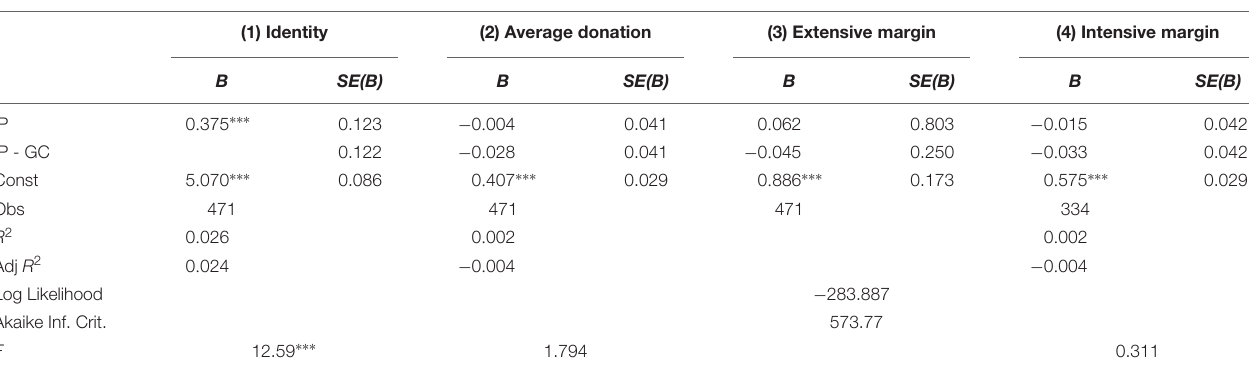
TABLE 5 | Effect of the self-identity prime and goal commitment in Study